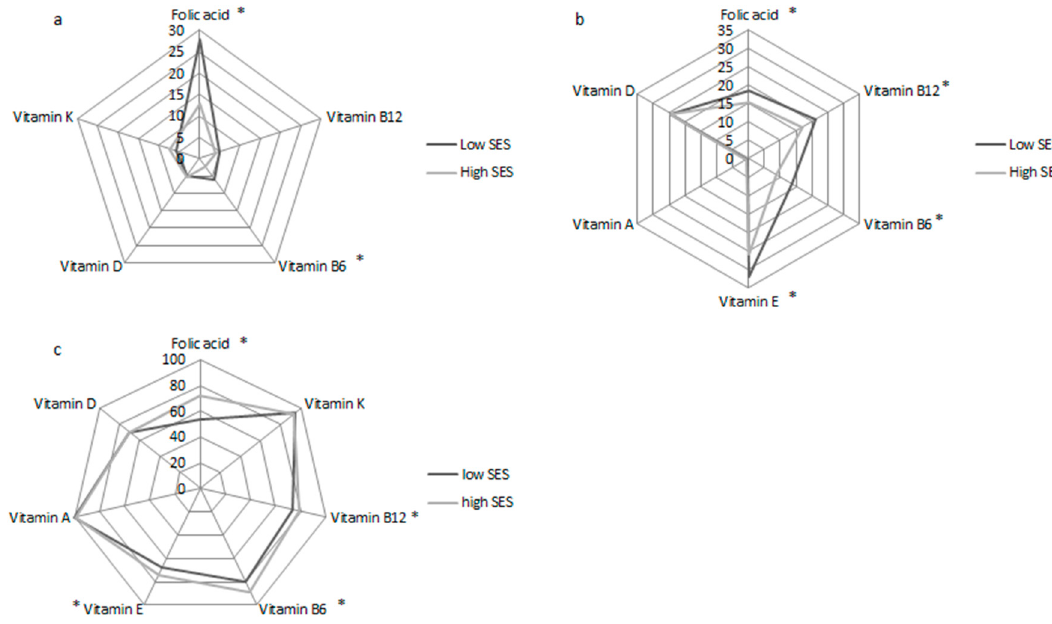
Figure 2. Prevalence (%) of vitamin deficiency ( a ), insufficiency ( b ), and adequate status ( c ) in low and high SES groups. * significant difference between low and high SES groups with p < 0.05. The cutoff values applied for folic acid status were serum folic acid < 10.2 nmol/L, 10.2–13.6 nmol/L, and > 13.6 nmol/L for deficiency, insufficiency, and sufficient status, respectively. Vitamin K insufficiency was defined as desphospho-uncarboxylated matrix Gla protein (dp-ucMGP) level higher than 500 pmol/L. The cutoff values employed for vitamin B12 status were serum vitamin B12 < 150 pmol/L, 150-220 pmol/L, and > 220pmol/L for deficiency, insufficiency, and sufficient status, respectively. The cutoff values used for serum vitamin B6 status, were serum vitamin B6 < 20 nmol/L, 20–30 nmol/L, and > 30 nmol/L for deficiency, insufficiency, and sufficient status, respectively. Serum alpha-tocopherol levels below 30 μ mol/L were considered indicating vitamin E insufficiency. Vitamin A insufficiency was defined as serum retinol concentration below 0.7 μ mol/L. The cutoff values applied for vitamin D status, were serum 25-hydroxyvitamin D (25(OH)D) < 30 nmol/L, 30-50 nmol/L, and > 50nmol/L for deficiency, insufficiency, and sufficient status, respectively.